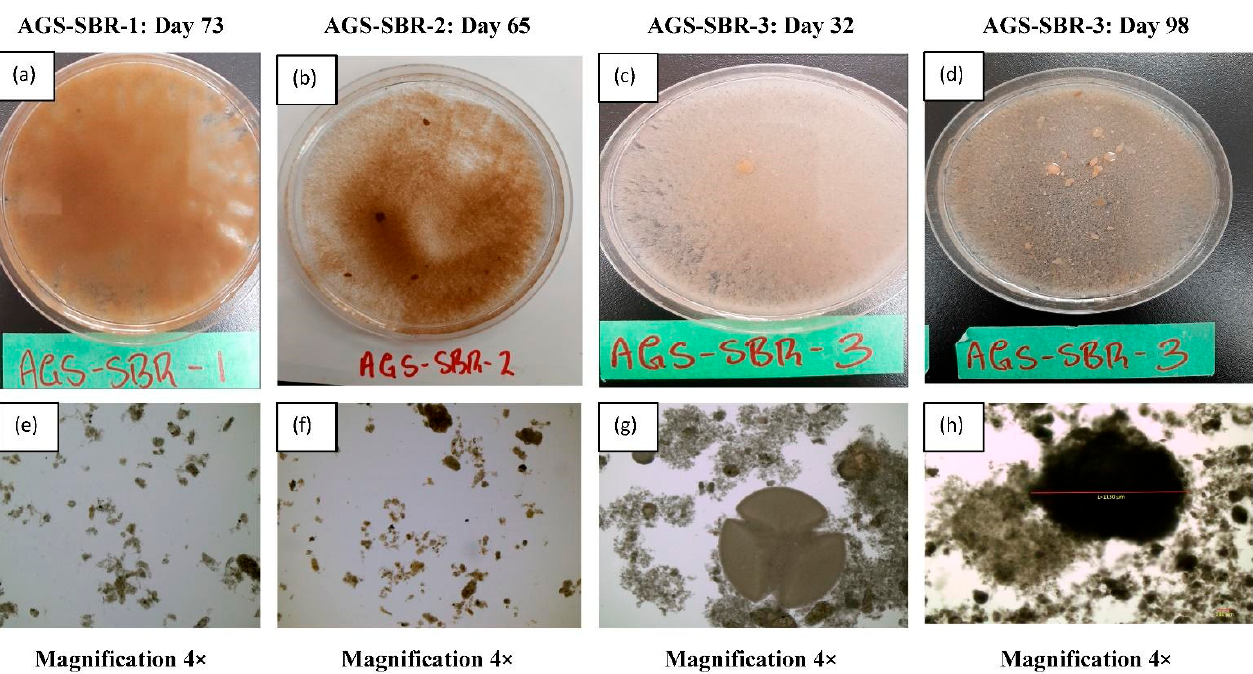
Figure 3. Images of sludge morphology in AGS-SBR-1 ( a , e ), AGS-SBR-2 ( b , f ), and AGS-SBR-3 ( c , d , g , h ).